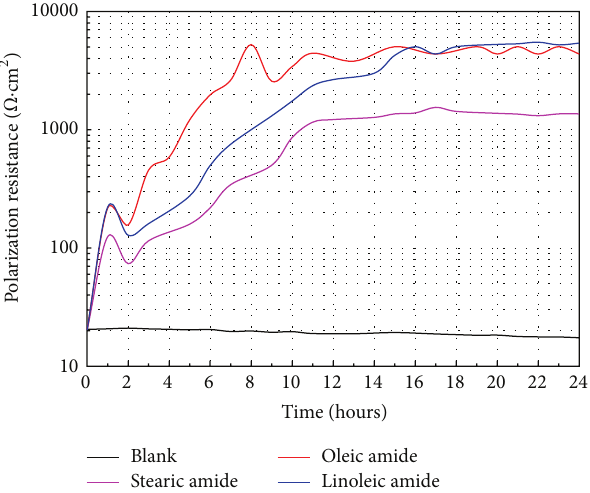
Figure 4: Change of 𝑅 𝑝 values function of testing time for 1018 carbon steel in CO 2 -saturated (3% NaCl + 10% diesel) emulsion with and without fatty-amides at 50 ∘ C.